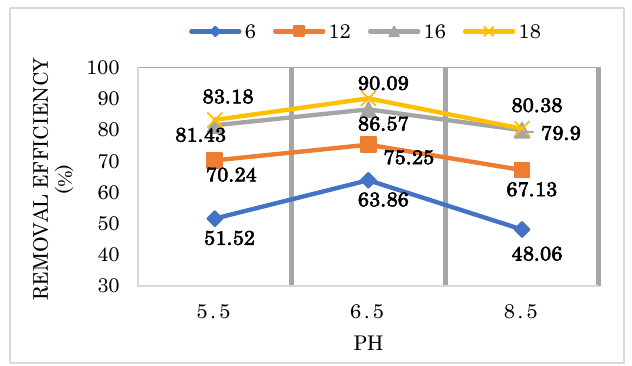
Fig. 4. pH optimization for turbidity removal for 1.5